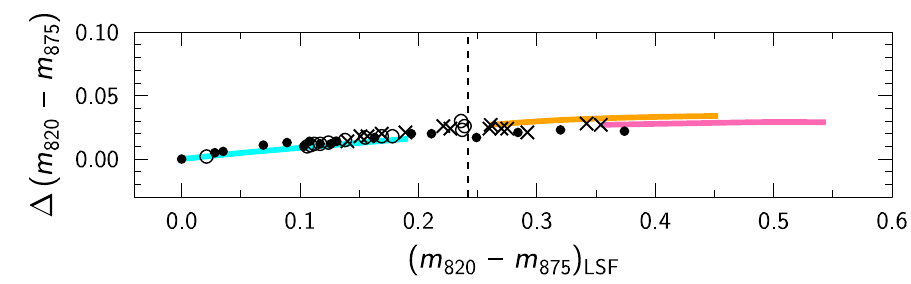
Fig. 10d. Decontamination corrections for the magnitude m 820 .